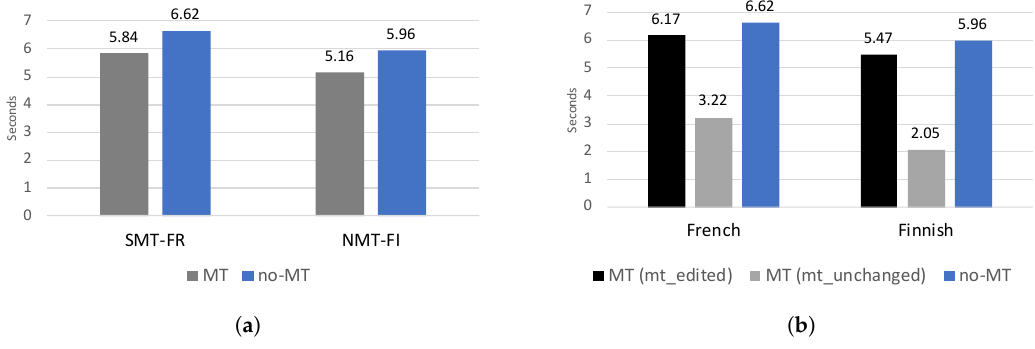
Figure 2. Average processing speed (expressed in seconds per source token) for all translators, per segment type and per language